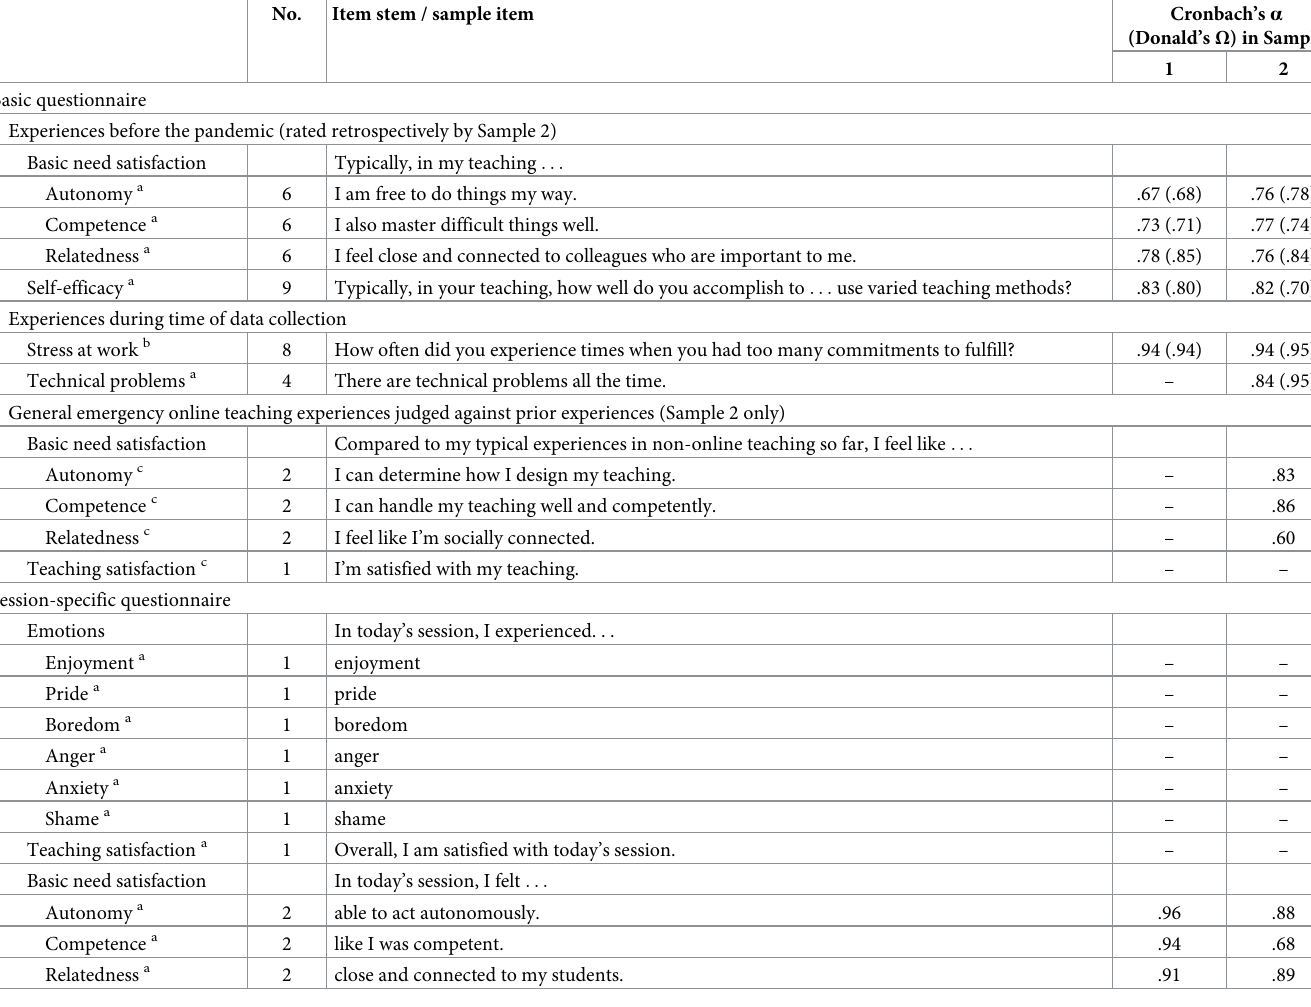
Table 1. Number of items, sample items, and reliability indicators for both samples of all study variables. No. Item stem / sample item